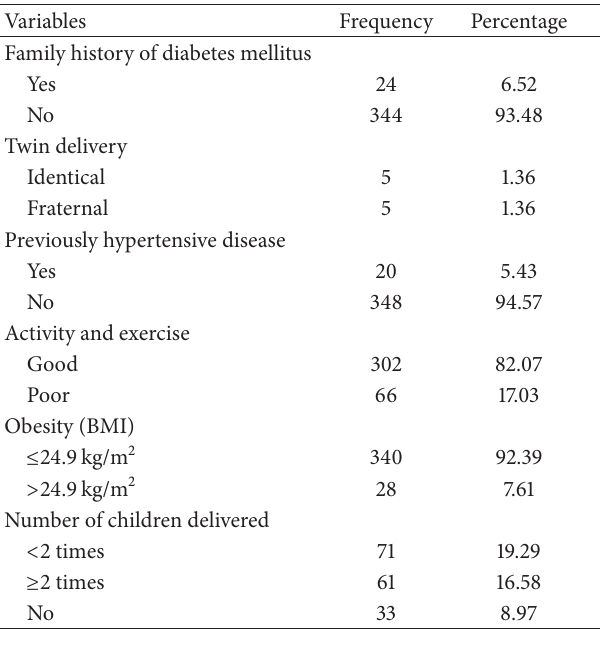
Table 3: Associated factors among patients in Debre Berhan Refer- ral Hospital in June 2015.